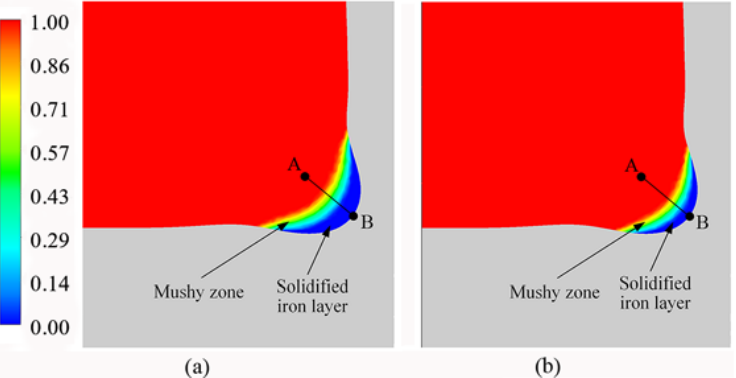
Figure 14. The volume fraction of hot iron on Section C: ( a ) 1480.1 °C tapping temperature; ( b ) 1519.7 °C tapping temperature.